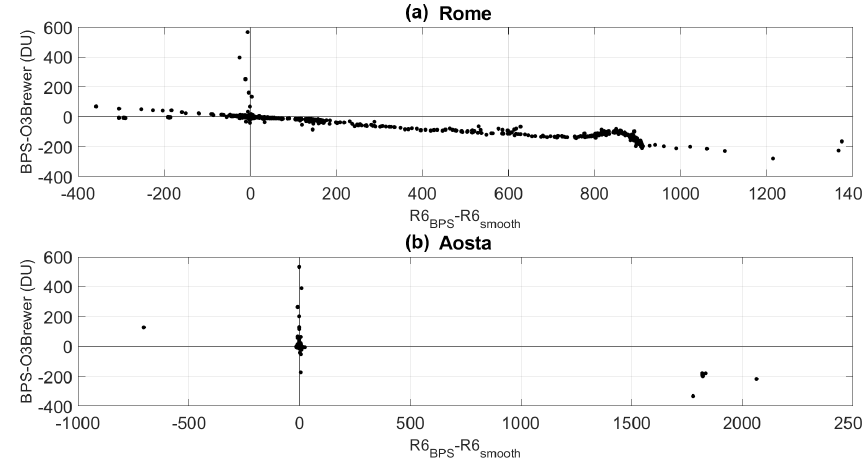
Figure 7. Differences between BPS and O3Brewer TOC daily means vs. R 6 BPS – R 6 smooth at Rome (a) and at Aosta (b)